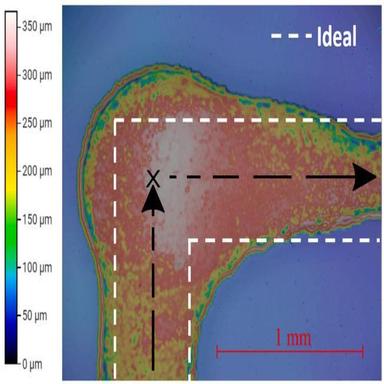
Optical profilometry image of the corner of a rectilinear printed sample from flow consistency analysis. The dashed black lines represent the nozzle speed (smaller = slower), with arrows indicating the direction and the x indicating the zero velocity point.